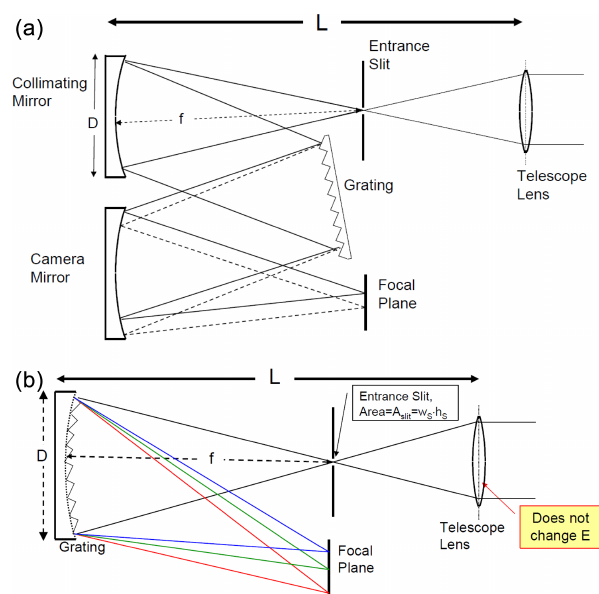
Figure 1. Typical design of DOAS spectrographs with telescope: (a) (symmetrical) Czerny–Turner spectrograph plus telescope. The size of the spectrograph L is largely determined by the focal length f . Its F number is given by the ratio of focal length f and diameter of the optics, D . The étendue is a function of the F number and proportional to the slit area, which is a product of slit width ( w S , extension in dispersion direction) and slit height ( h S ). (b) Imaging spectrographs with a concave grating; L and the F number (see Eq. 6) are given in the same way as for the Czerny–Turner spectro- graph. Note that in both cases the étendue of the spectrograph is the same as that of the spectrograph + telescope